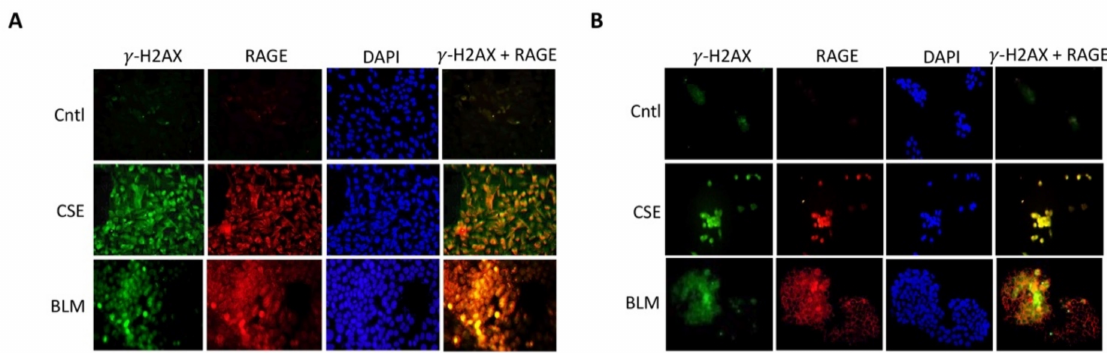
Figure 5. Trophoblastic DNA-DSBs and RAGE (IF). ( A , B ) Increased staining and co-localization of DNA-DSBs ( green , γ -H2AX), and RAGE ( Red ) was observed from CSE or BLM treated Sw.71 ( A ) and Bewo ( B ). Images (40 × magnification) are representative of experiments involving at least 6 different trophoblast experiments from each